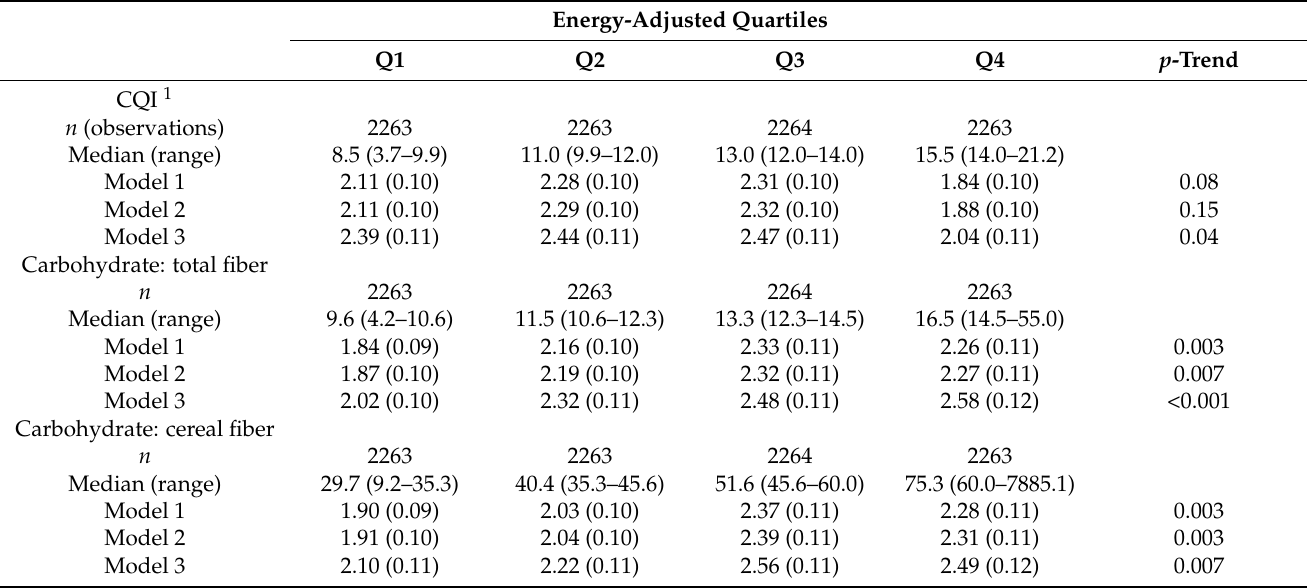
Table 5. Means (SE) of four-year change in waist circumference (cm) by quartiles of different carbohydrate quality metrics in 3101 participants of the Framingham Cohort